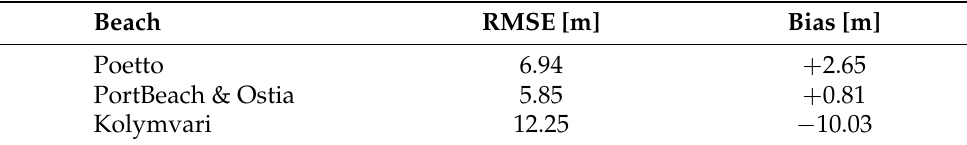
Figure 7. ( A ) Root mean square error (RMSE) and ( B ) Bias in meters between the SDS profile and the GT-digitised shorelines for each date and beach considered in the study. Table 6. Time-averaged RMSE and bias resulting from the comparison between the User GT shorelines and SDS profile comparison.